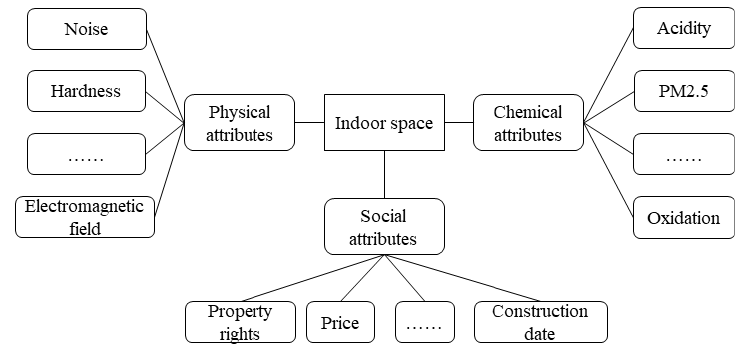
Figure 11. The attribute information of indoor space